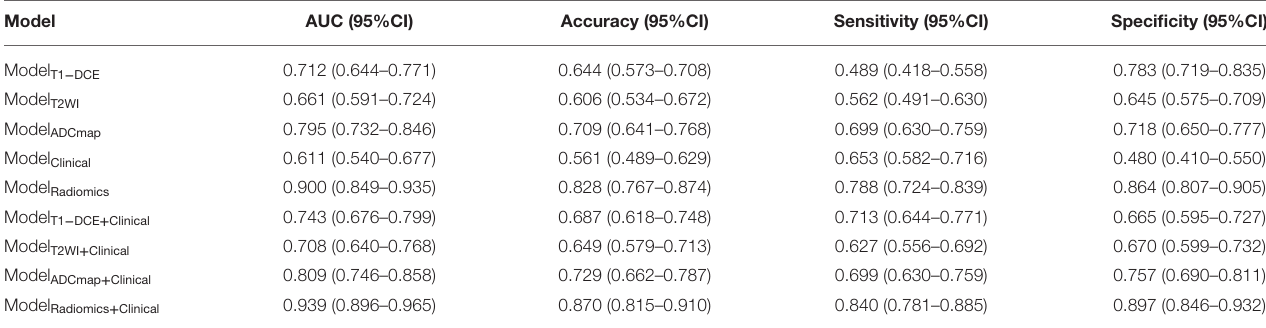
TABLE 3 | Diagnostic performances to classify tumor shrinkage pattern in testing dataset of different models based on the type of features using the Multilayer Perception (MLP) neural network.